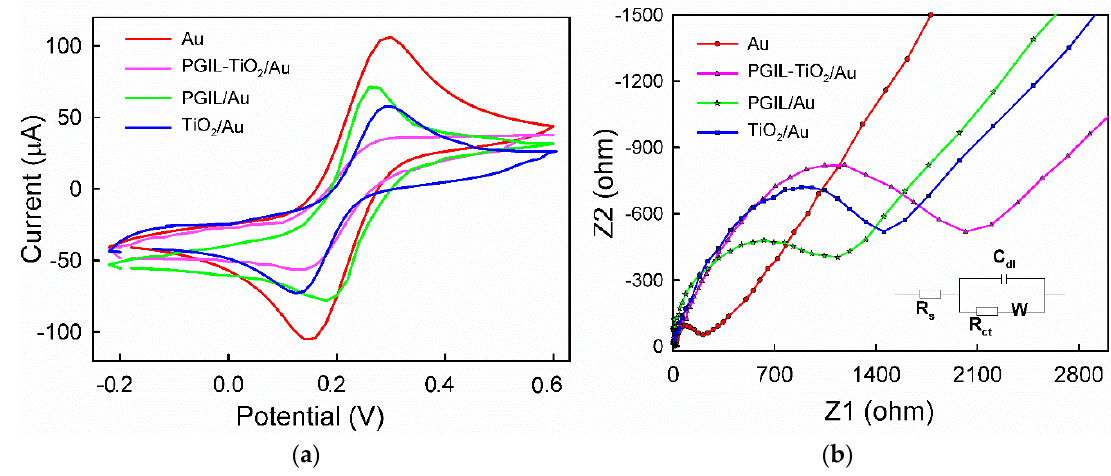
Figure 4. ( a )The cyclic voltammetry curves and ( b ) the EIS plots of PGDIL–TiO 2 / Au, PGDIL / Au, TiO 2 / Au, and Au in the presence of 5.0 mmol L − 1 Fe(CN) 63 − / 4 − with 0.1 mol L − 1 KCl as the electrolyte. The illustration equivalent circuit.